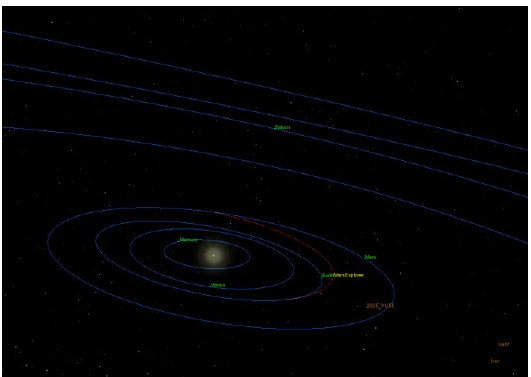
Figure 5a. Modeling and Visualization of planets of solar system